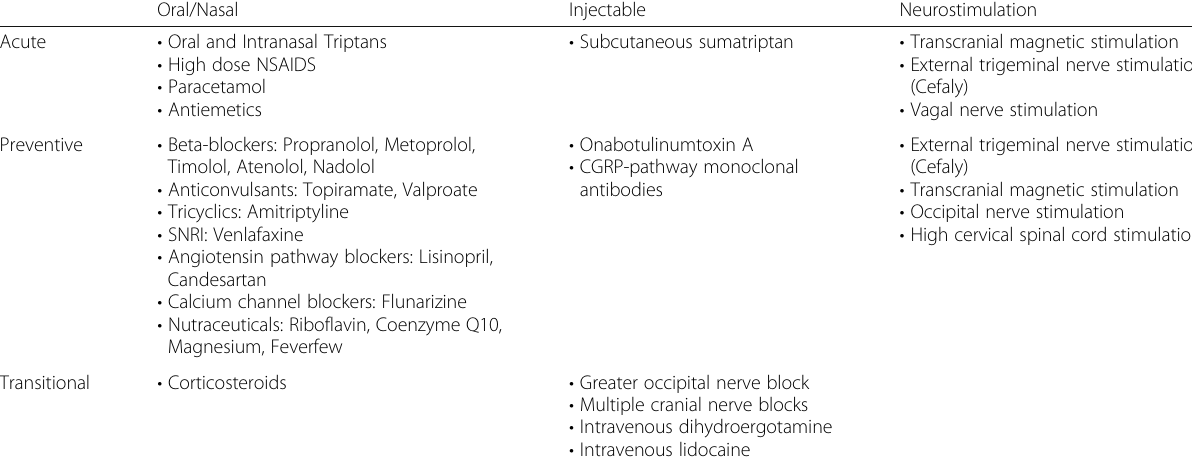
Table 3 Treatment options in the management of refractory migraine Oral/Nasal